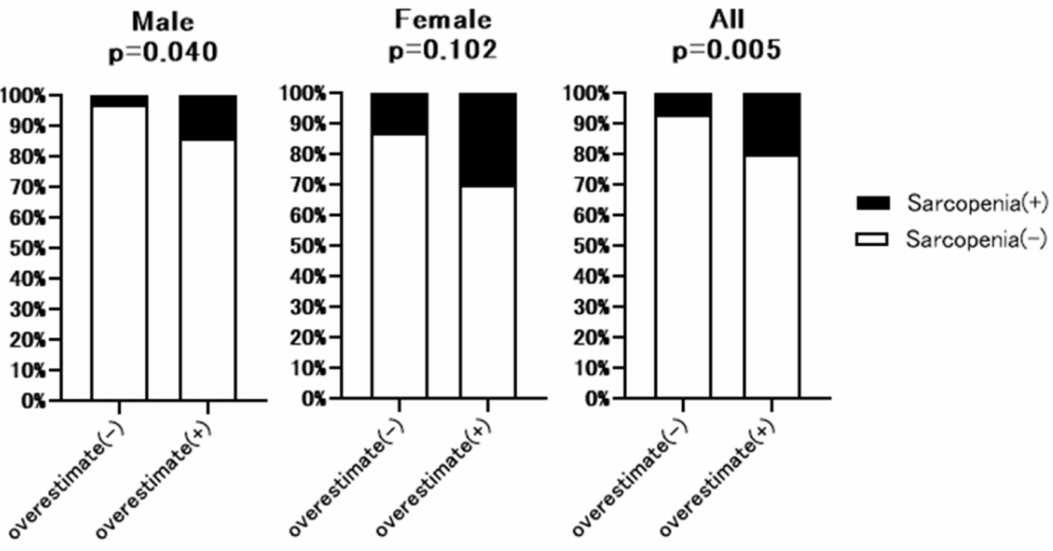
Figure 5. Comparison of the rate of sarcopenia between patients with or without overestimated renal function. Overestimate ( − ): patients without overestimated renal function. Overestimate (+): patients with overestimated renal function. LGS: Low hand grip strength. p -value indicates comparison of the Overestimate (+) group vs. Overestimate ( − )